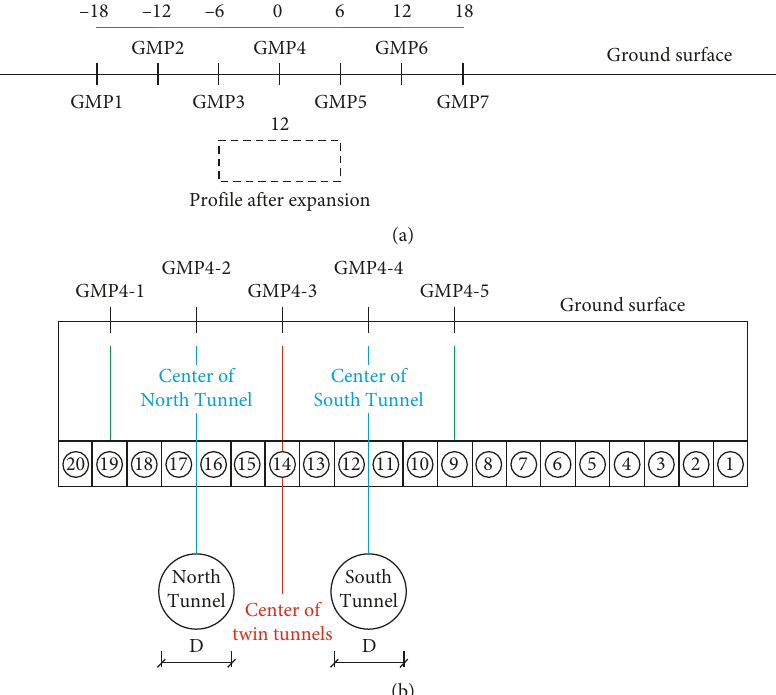
Figure 9: Layout of the monitoring points on the ground surface.